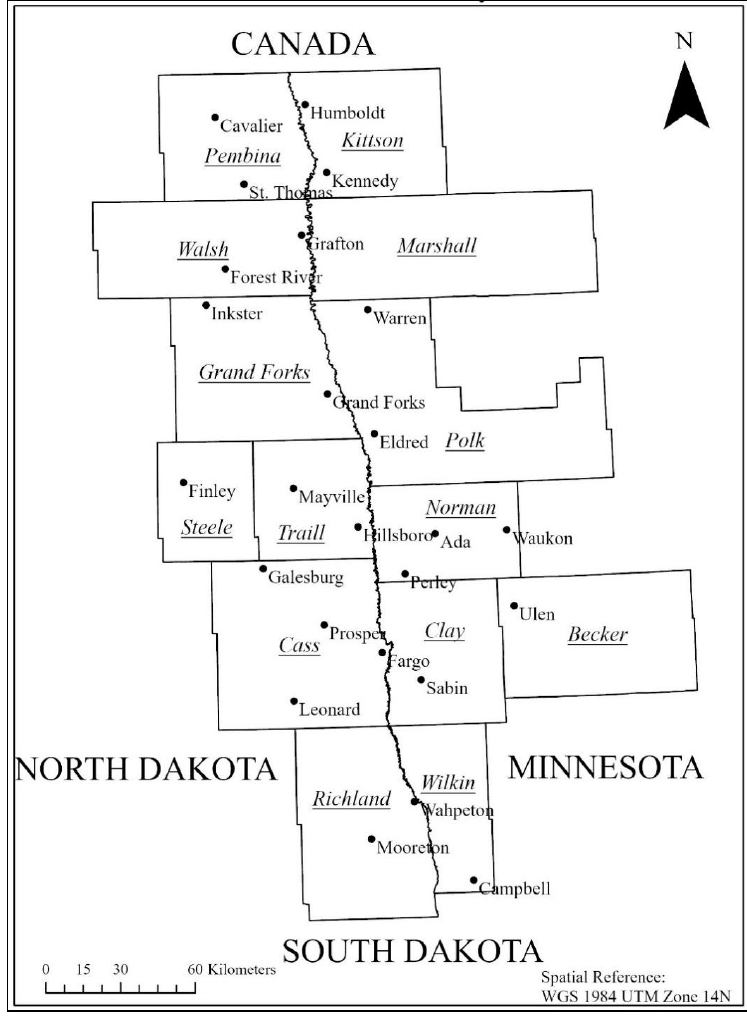
Figure 1. Map showing counties of North Dakota and Minnesota and weather stations in study area around Red River Valley. Black dots in map represent weather stations, and county names are in italics and underlined.